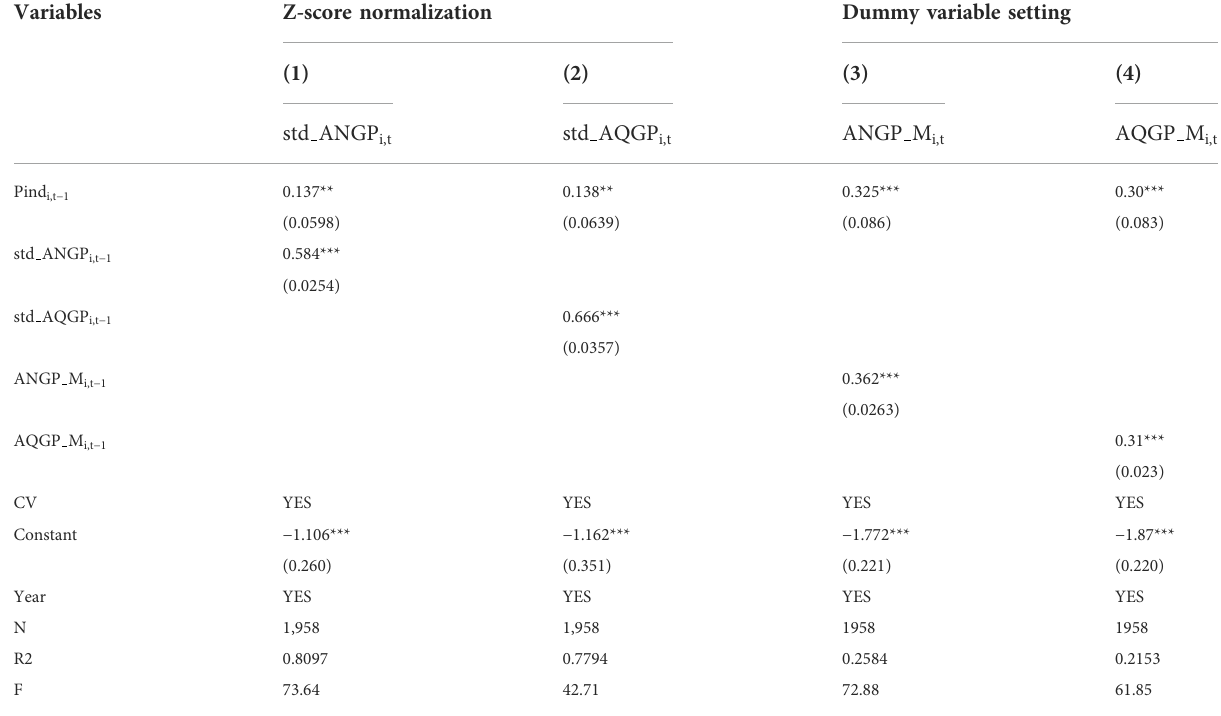
TABLE 4 Robust tests — Variable